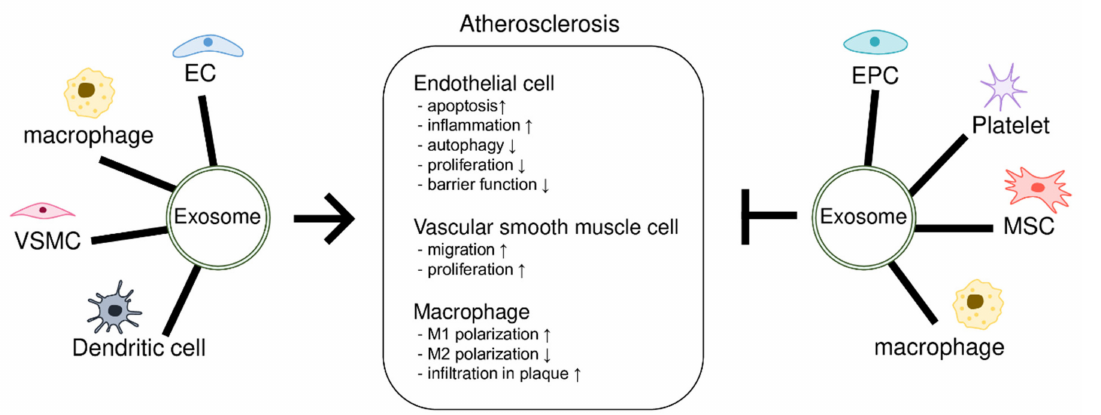
Figure 1. Exosome-mediated regulation of atherosclerosis. Vascular cells, macrophages, dendritic cells, endothelial progenitor cells (EPCs), and mesenchymal stem cells (MSCs) are involved in atherosclerosis through intercellular communication via exosomes. These cells release exosomes containing molecules that induce or inhibit atherosclerosis, depending on the type or physiological state of the cell. Recipient cells including endothelial cells (ECs), vascular smooth muscle cells (VSMCs), and macrophages show phenotypic changes associated with atherosclerosis. Arrow indi- cates induction of atherosclerosis; lines with a perpendicular line at the end indicate inhibition of